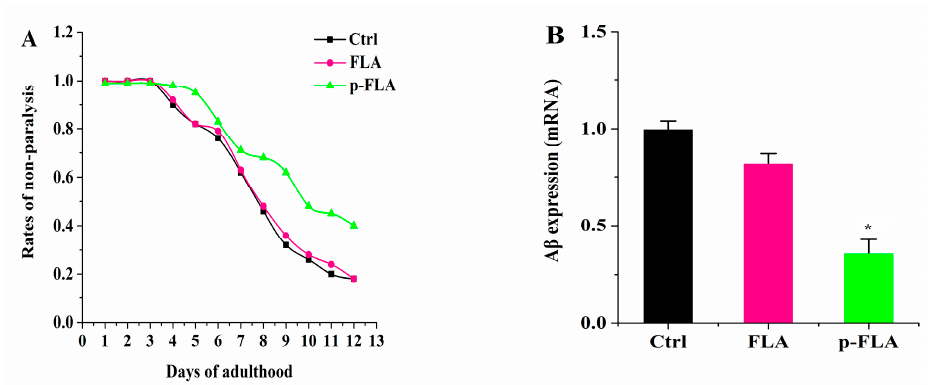
Figure 7. Effect of FLA and p-FLA in A β -expressing nematode model strain CL2006. ( A ): 2 mg/mL p-FLA extracts significantly delayed A β -induced paralysis in this transgenic worm from Day 1 to Day 12; ( B ): 2 mg/mL p-FLA extracts reduced the level of A β by half. Error bars represent means ± SEMs (* p < 0.05).